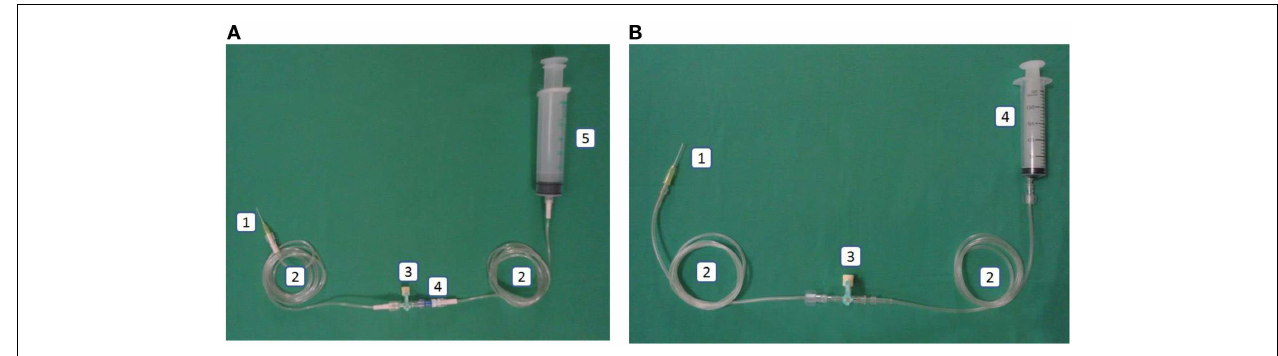
syringe. (B) Control: arterial line in the open catheter access system . 1. Intravascular cannula, 2. Extension tube slip tip, 3.Three-way stopcock, 4. Heparin saline in slip tip syringe.